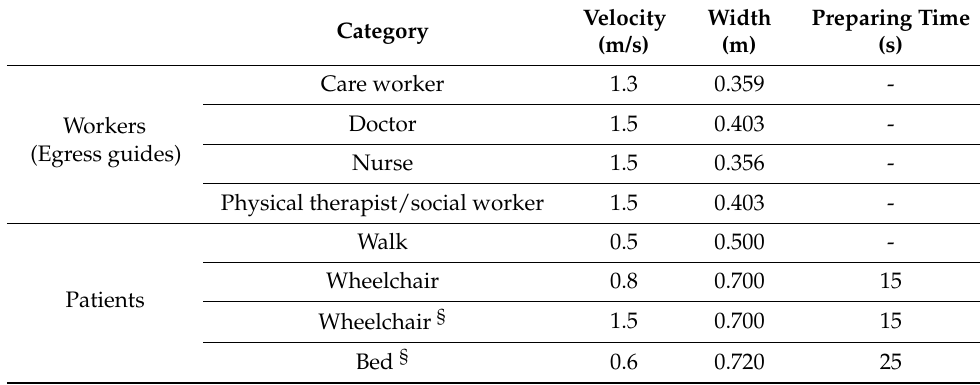
Table 5 lists the egress characteristics of patients and egress guides in nursing hospitals. The velocity and width of patients and egress guides were determined based on the egress type according to Lee et al. [2]. In addition, 15 and 25 s required to attach or set up assistive devices were considered for patients evacuated in wheelchairs and beds, respectively. The Enforcement Rule of Welfare of Senior Citizens Act in South Korea [35] stipulates that, for 150 patients, at least one doctor, six nurses, two physical therapists or social workers, and more than 60 care workers must be employed. During the simulations, these categories of workers were assumed to be egress guides to help patients egress. In nursing hospitals, staff typically work in shifts, and workers in night shifts are fewer than those in day shifts. Therefore, egress simulations in this study were performed using the number of workers as a variable. The number of workers for the egress simulation model ranged from 10 to 75 in intervals of five. Table 6 lists the types of workers in each case, and it was assumed that half of them would be in the room on the first and second floors, respectively. Table 5. Characteristics of occupants.